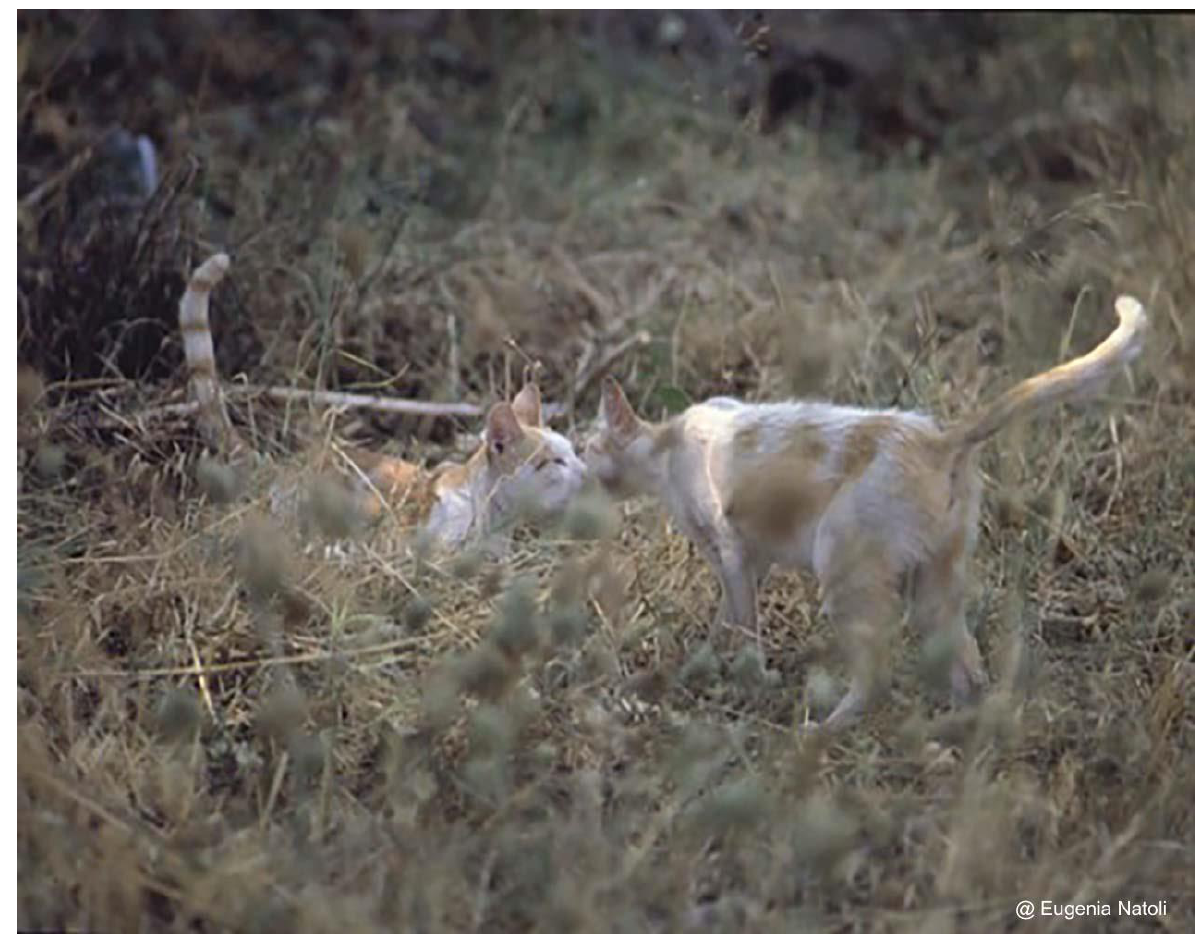
Figure 3. An adult female (on the right ) and an adult male (on the left ) belonging to the same social group. They are showing the affiliative behaviour ‘touching nose’ with their tails up [35] (credit Eugenia Natoli).